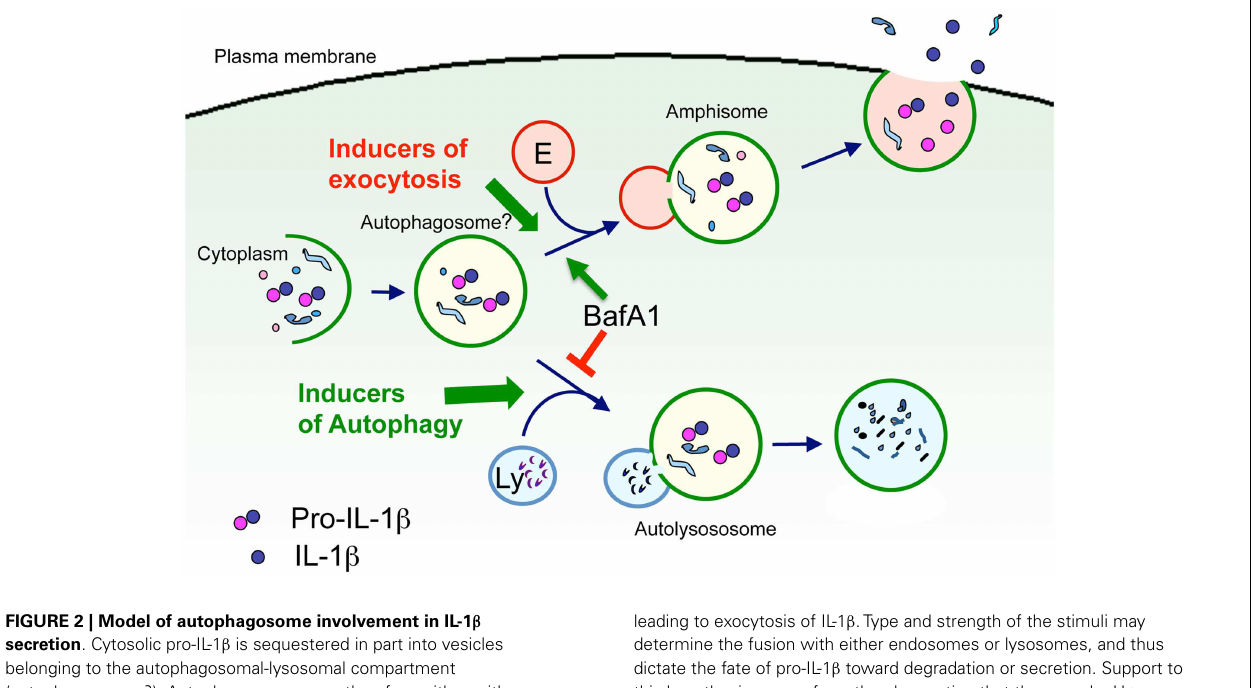
FIGURE 2 | Model of autophagosome involvement in IL-1 β secretion . Cytosolic pro-IL-1 β is sequestered in part into vesicles belonging to the autophagosomal-lysosomal compartment (autophagosomes?). Autophagosomes may then fuse either with lysosomes (Ly), resulting in degradation of pro-IL-1 β , or with endosomes (E) to form amphisomes, were pro-IL-1 β may undergo processing. Amphisomes then fuse with the plasma membrane